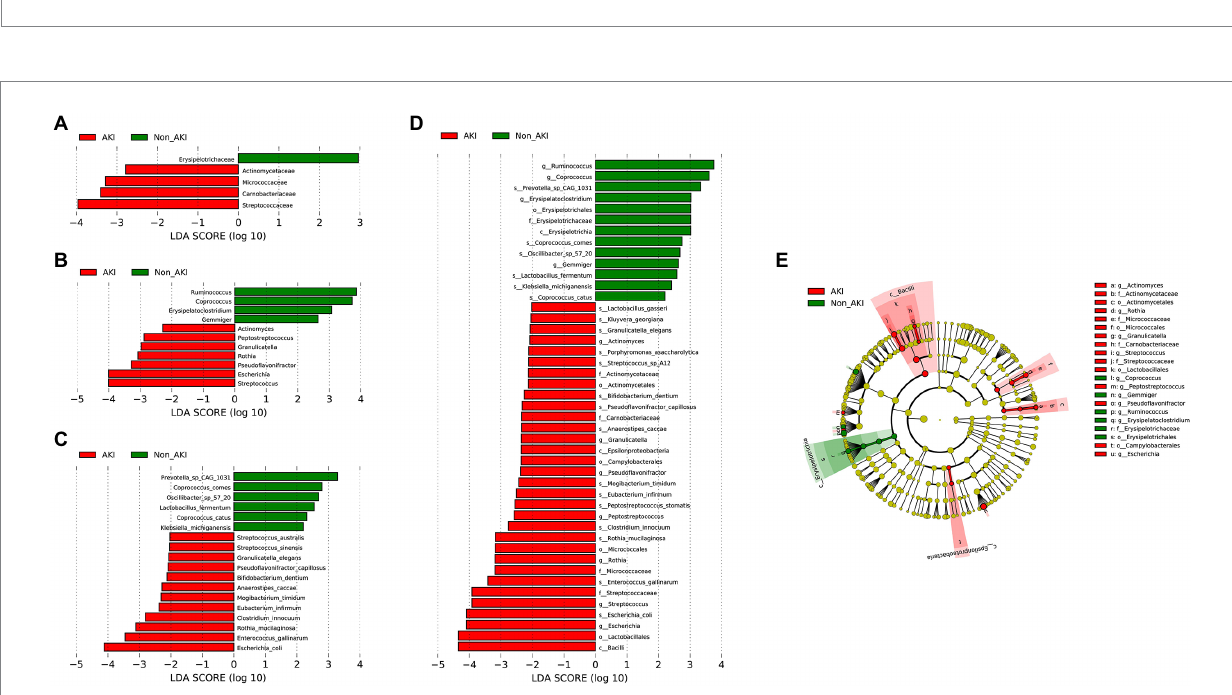
FIGURE 4 Variations in fecal microbiota composition determined by linear discriminant analysis (LDA) effect size analysis, LDA > 2.0, p < 0.05. AKI vs. Non_AKI at the family level (A) , the genus level (B) , the species level (C) , and the overall level (D) . (E) Taxonomic cladogram obtained from LEfSe analysis.